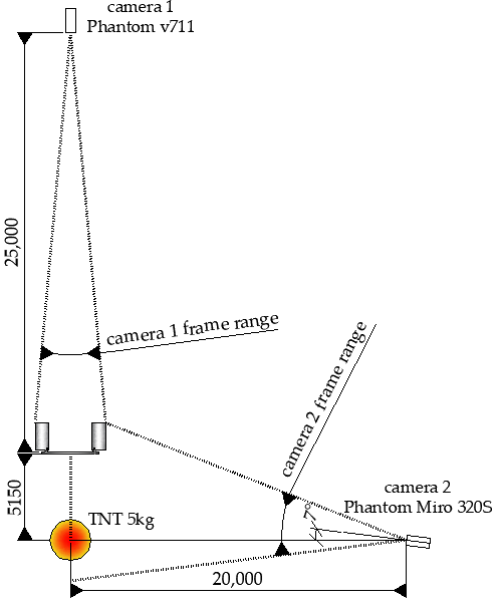
Figure 5. The positions of the cameras in relation to the tested structure (dimensions are in